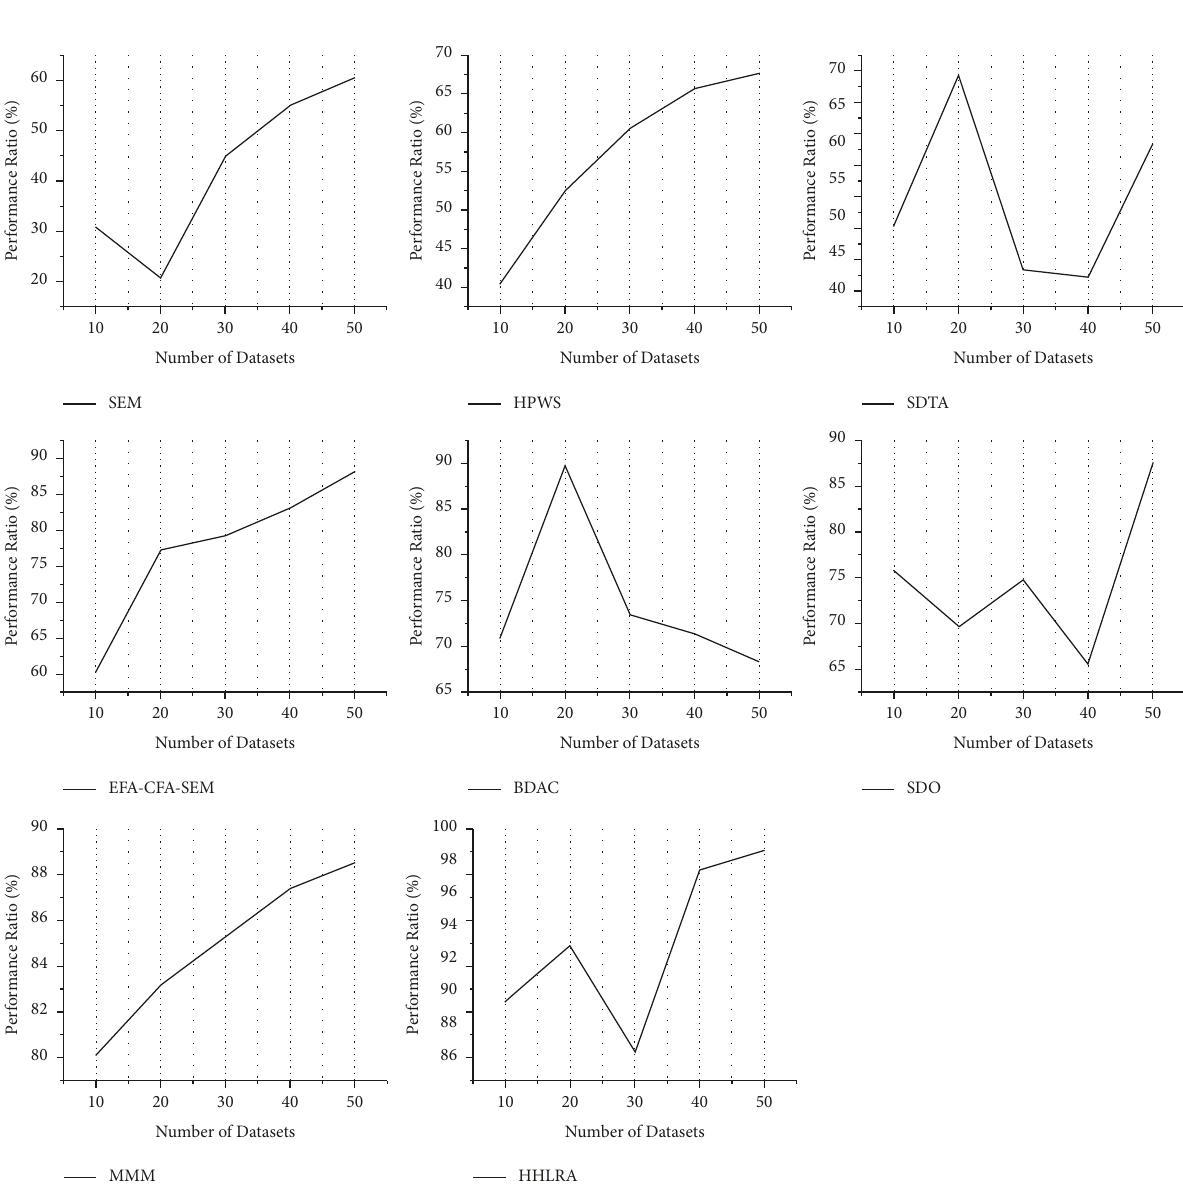
Figure 5: Knowledge Performance gain. Table 2: Balanced Performance